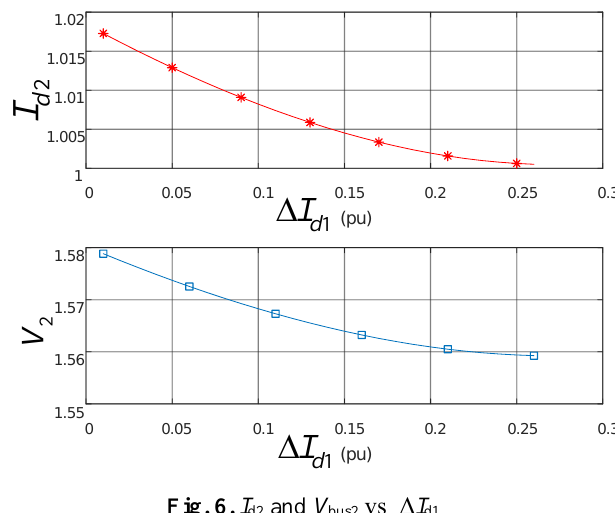
Fig. 6. I d2 and V bus2 vs Δ I d1